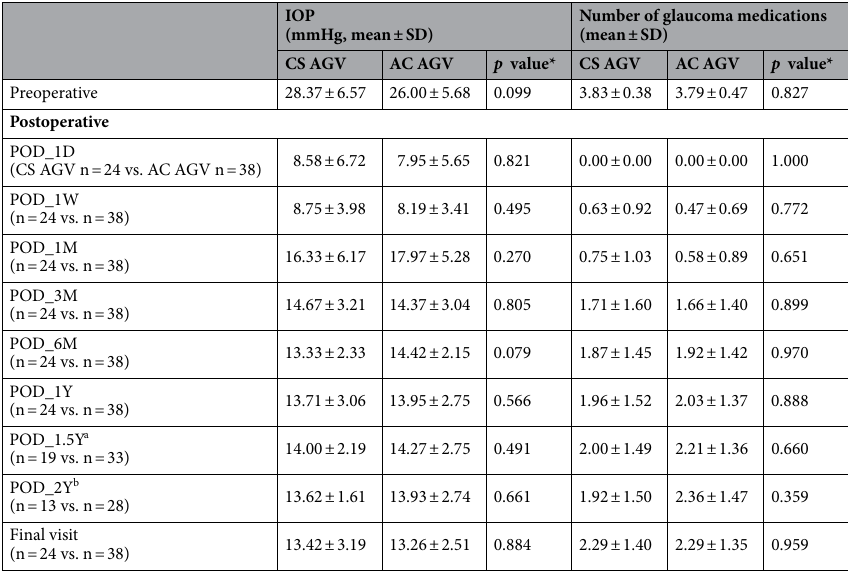
Table 2. Preoperative and postoperative intraocular pressure and number of glaucoma medications after ciliary sulcus and anterior chamber Ahmed glaucoma valve procedures. SD standard deviation, CS AGV ciliary sulcus Ahmed glaucoma valve, AC AGV anterior chamber Ahmed glaucoma valve, IOP intraocular pressure, POD postoperative day, D day, W week, M month, Y year. *Mann–Whitney test. a Number of patients for csAGV and acAGV are 19 and 33, respectively. b Number of patients for csAGV and acAGV are 13 and 28, respectively. For those not mentioned, 24 csAGV and 38 acAGV cases were compared. Values are presented as the mean ± standard deviation.